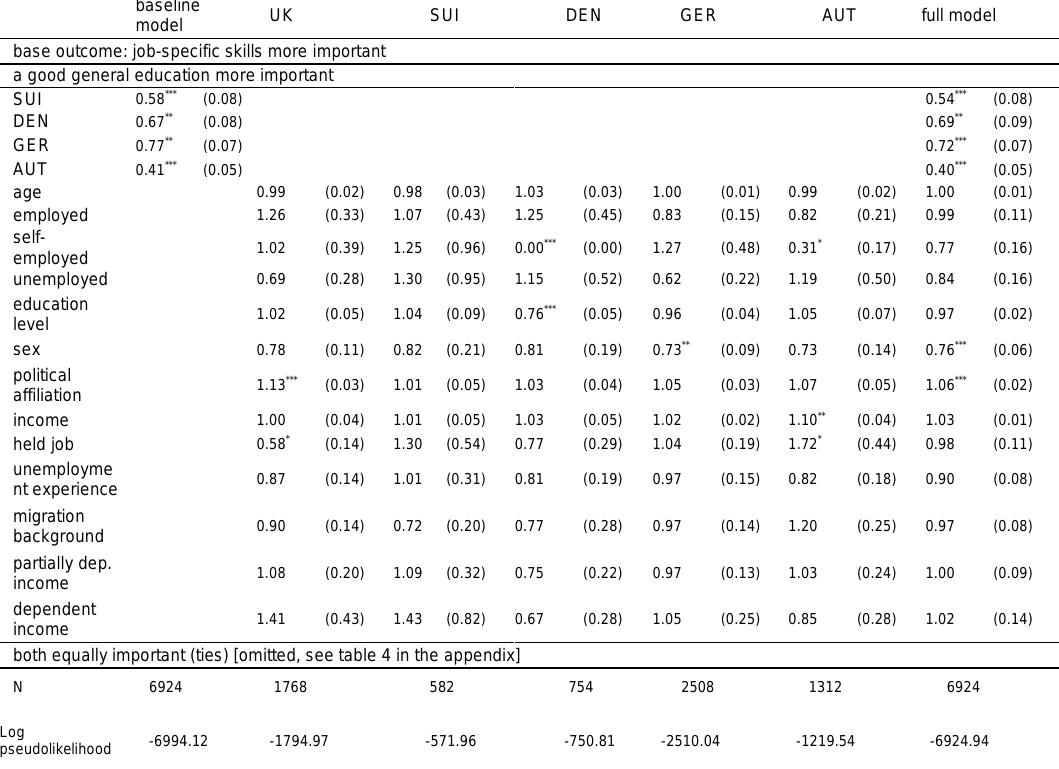
Table 4. Multinomial logistic models for the comparison of skill